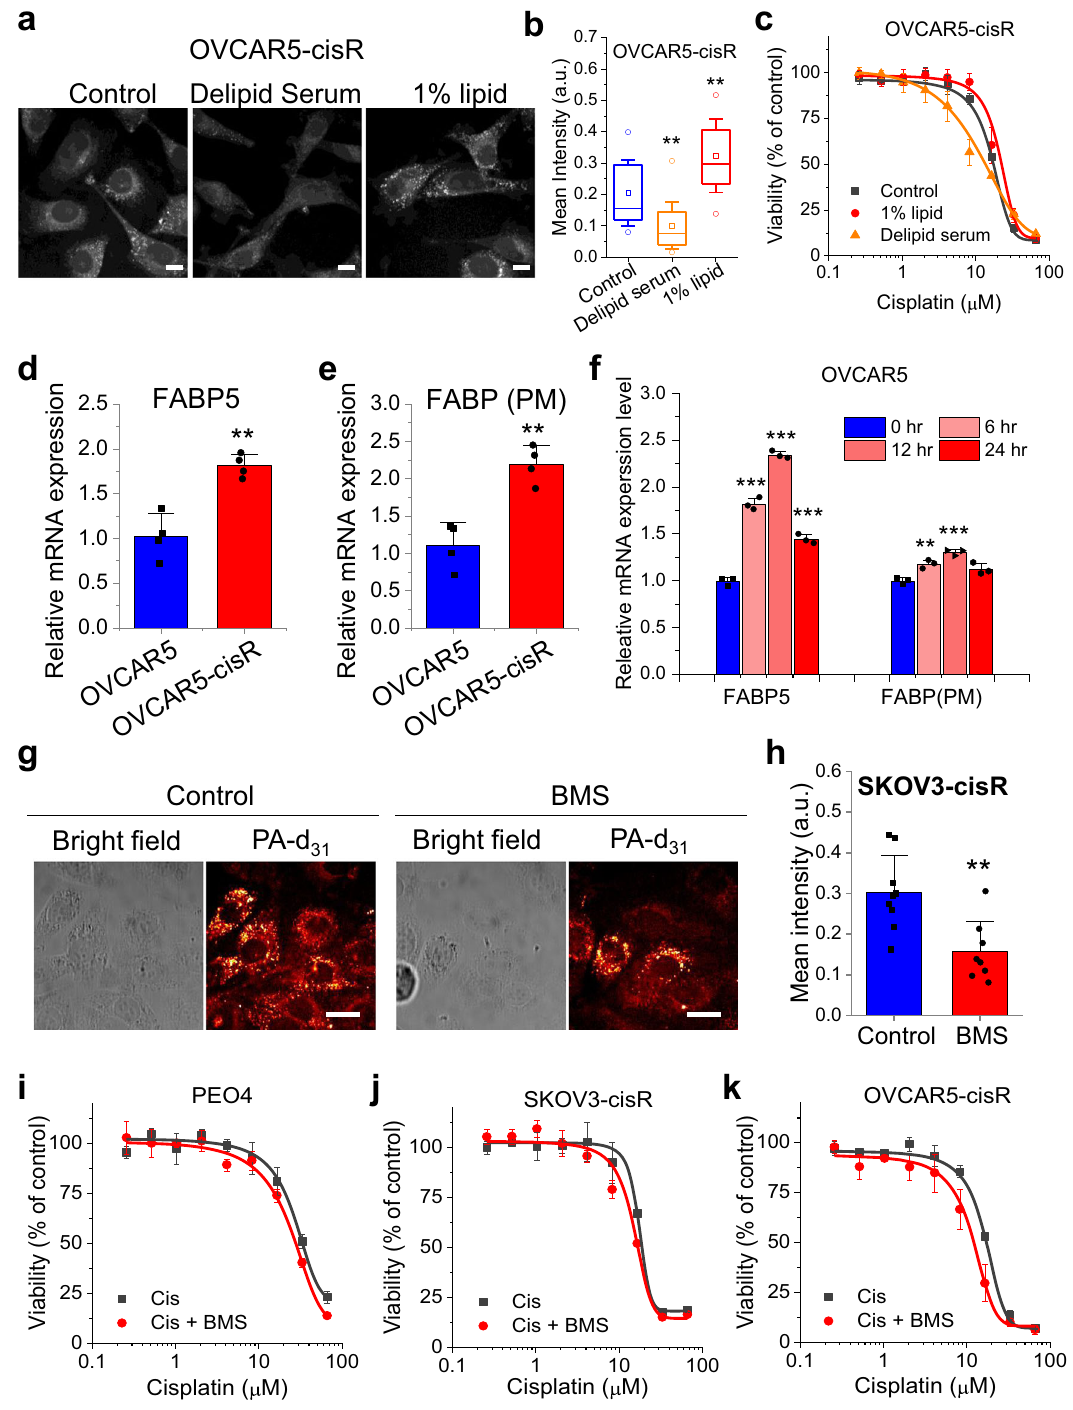
Fig. 4 | FA uptake directly contributes to cisplatin resistance. a SRS image of OVCAR5-cisR cell cultured with control serum (FBS), delipid serum or control serum supplemented with 1% lipid mixture for 24h. b Quantitative C-H signal from lipid droplet for a . The outer box, inner box, lines, whiskers and circles indicates 25% to 75% of data, mean, medium, SD, maxima and minima respec- tively. n =15 technical replicates. P =0.0043 and 0.0072. c Dose-response to cisplatinundercultureenvironmentwithcontrol,reduced(mediumcontaining delipid serum) and increased (control serum supplemented with 1% lipid mix- ture) lipid content for OVCAR5-cisR cells. d , e Relative mRNA expression level of FABP5 (d) and FABP(PM) ( e ) in OVCAR5 and -cisR cells. n =4. P =0.0037 and 0.0018. f Relative mRNA expression level of FABP5 and FABP(PM) in OVCAR5 cells treated with cisplatin for 0, 6, 12 or 24h. n =3. P =0.00016, 2.4× 10 − 6 ,